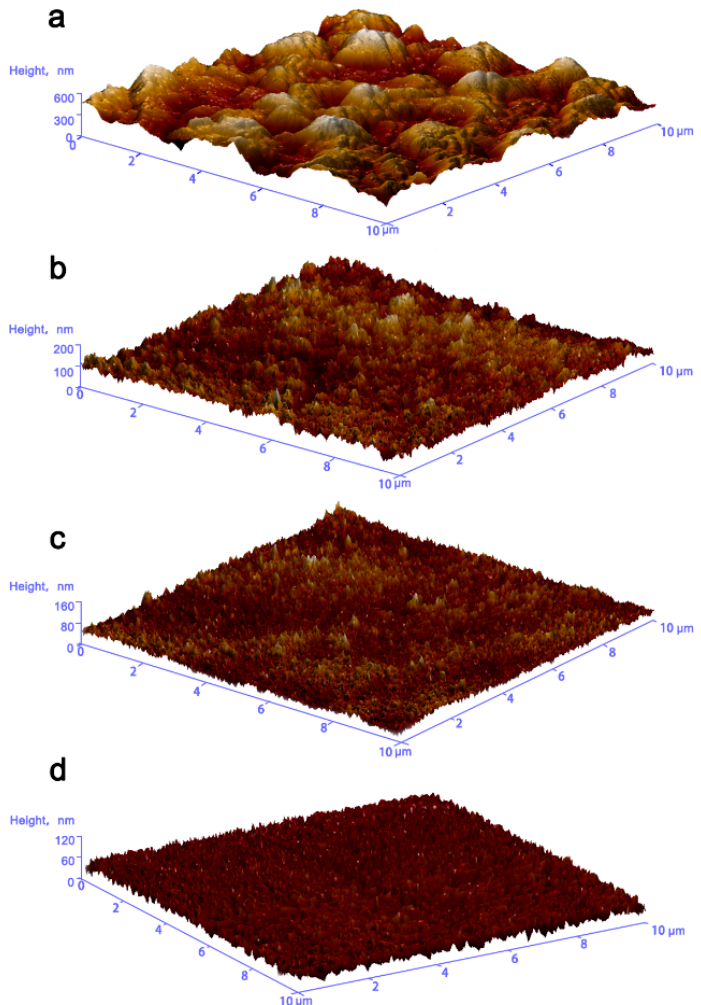
Figure 8. AFM images of Al coatings deposited at 10 mA/cm 2 for 30 min from AlCl 3 -EMIC ionic liquids containing ( a ) no and 6 mM of ( b ) 2-cyanopyridine, ( c ) 3-cyanopyridine, and ( d ) 4-cyano-